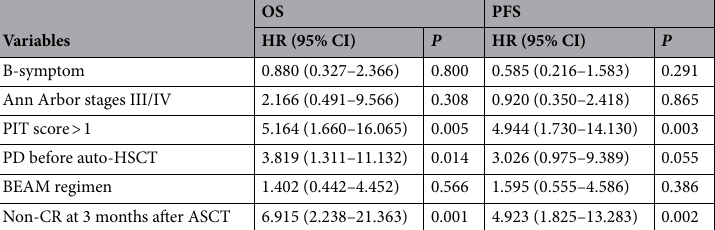
Table 4. Univariate analysis of factors potentially associated with OS and PFS. PIT, the T cell lymphoma prognostic index; PD, progressive disease; CR, complete response; ASCT, autologous stem cell transplantation.